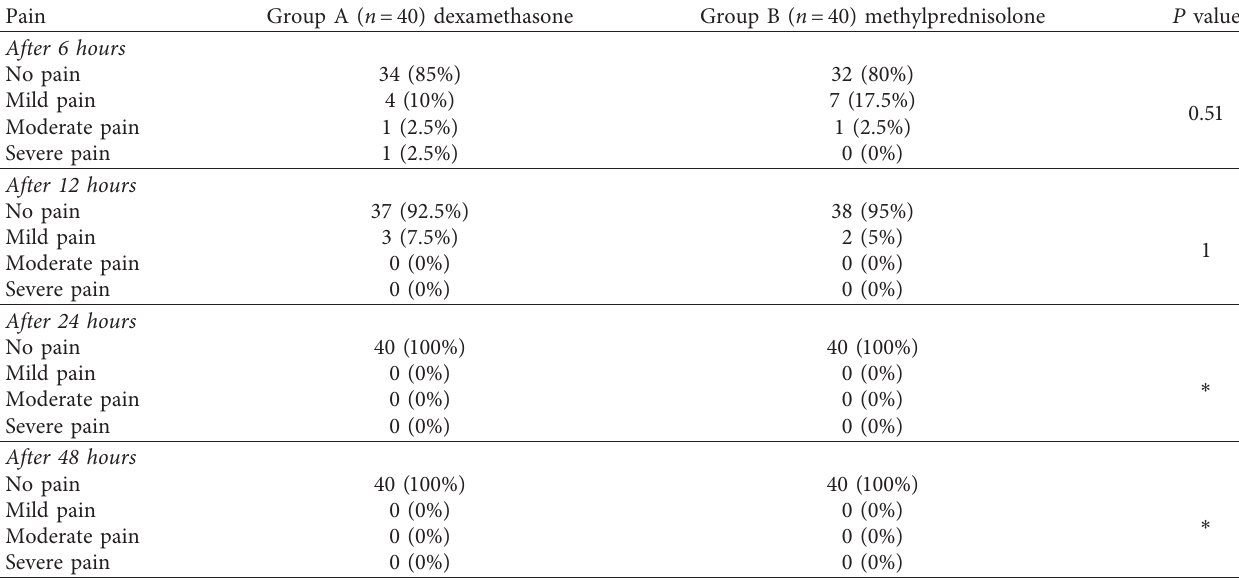
Table 1: Association of visual analogue score with group A and group B at 6, 12, 48, and